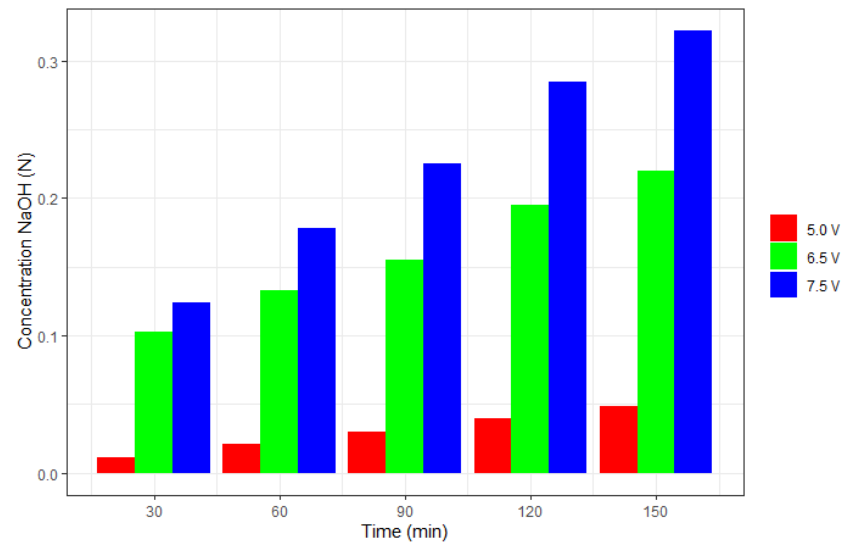
Figure 5. Effect of applied voltage on NaOH concentration at 25 ◦ C and 0.01 N.